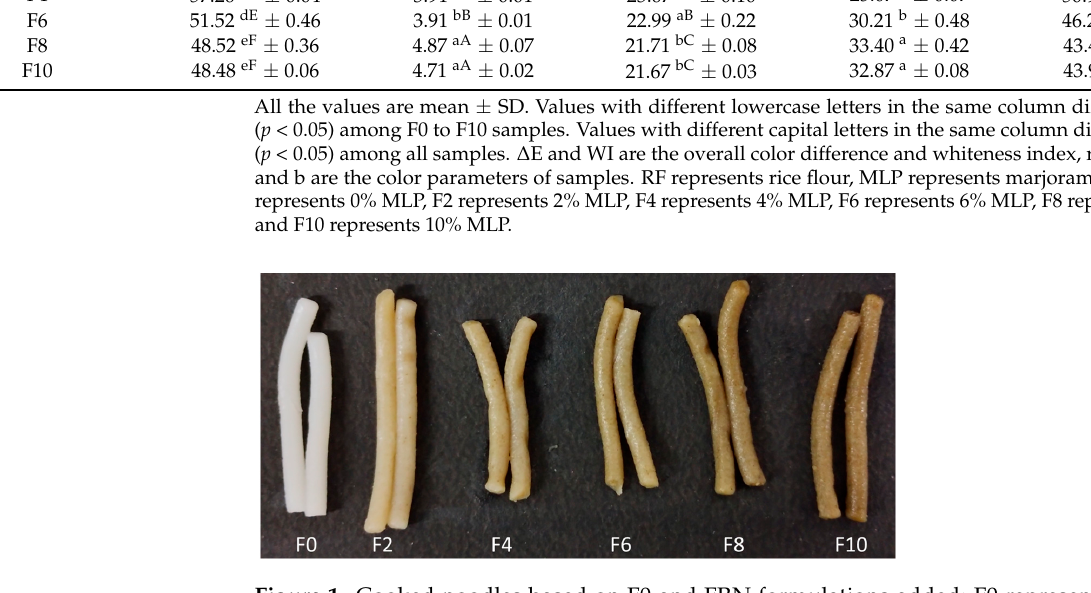
Figure 1. Cooked noodles based on F0 and FRN formulations added; F0 represents 0% MLP, F2 represents 2% MLP, F4 represents 4% MLP, F6 represents 6% MLP, F8 represents 8% MLP, and F10 represents 10% Table 2. Color characteristics of the RF, MLP, and FRN.